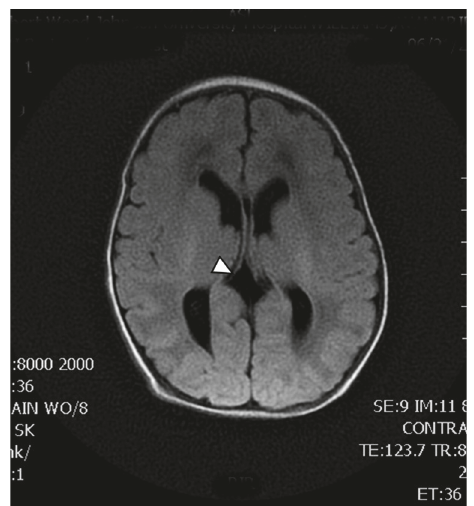
Figure 6: Arachnoid cyst at the velum interpositum (arrow).